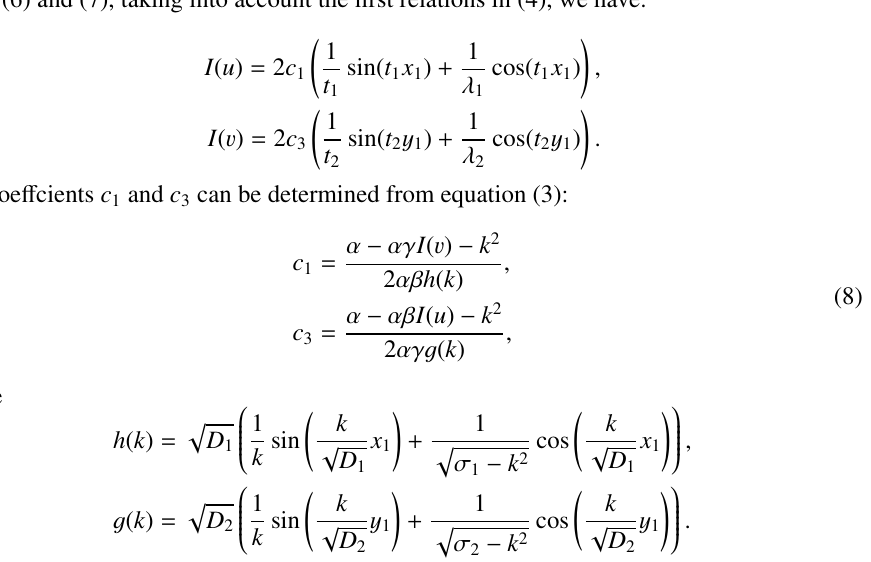
( σ 2 ): constant values α = 1, σ 1 = 4. Right: y ∗ ( x ∗ ): Black line σ 1 = σ 2 . Concave Figure 1. Left: y ∗ 1 1 1 part of the I and convex part of III quadrant σ 1 < σ 2 : k = 0 . 448. Convex part of the I and concave part of III quadrant σ 1 > σ 2 : k = 0 . 448.